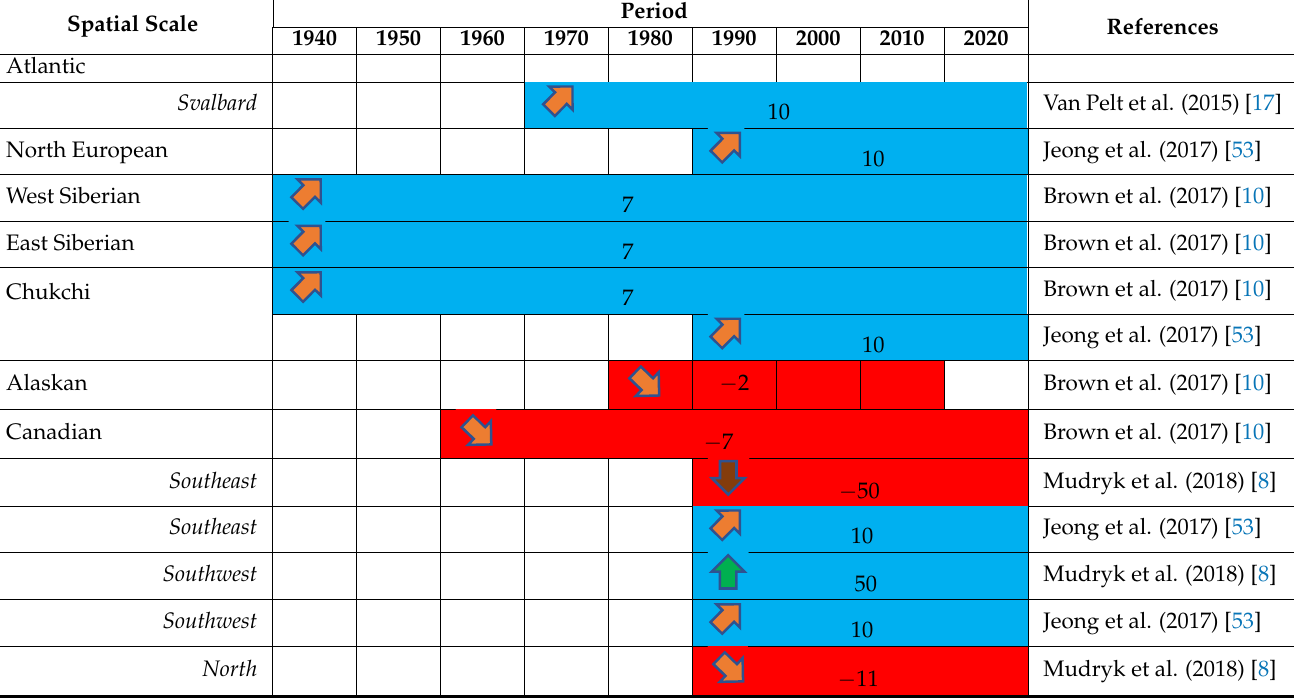
ward arrow: strongly negative; oblique downward arrow: slightly negative; horizontal arrow: no trend). − 0.2